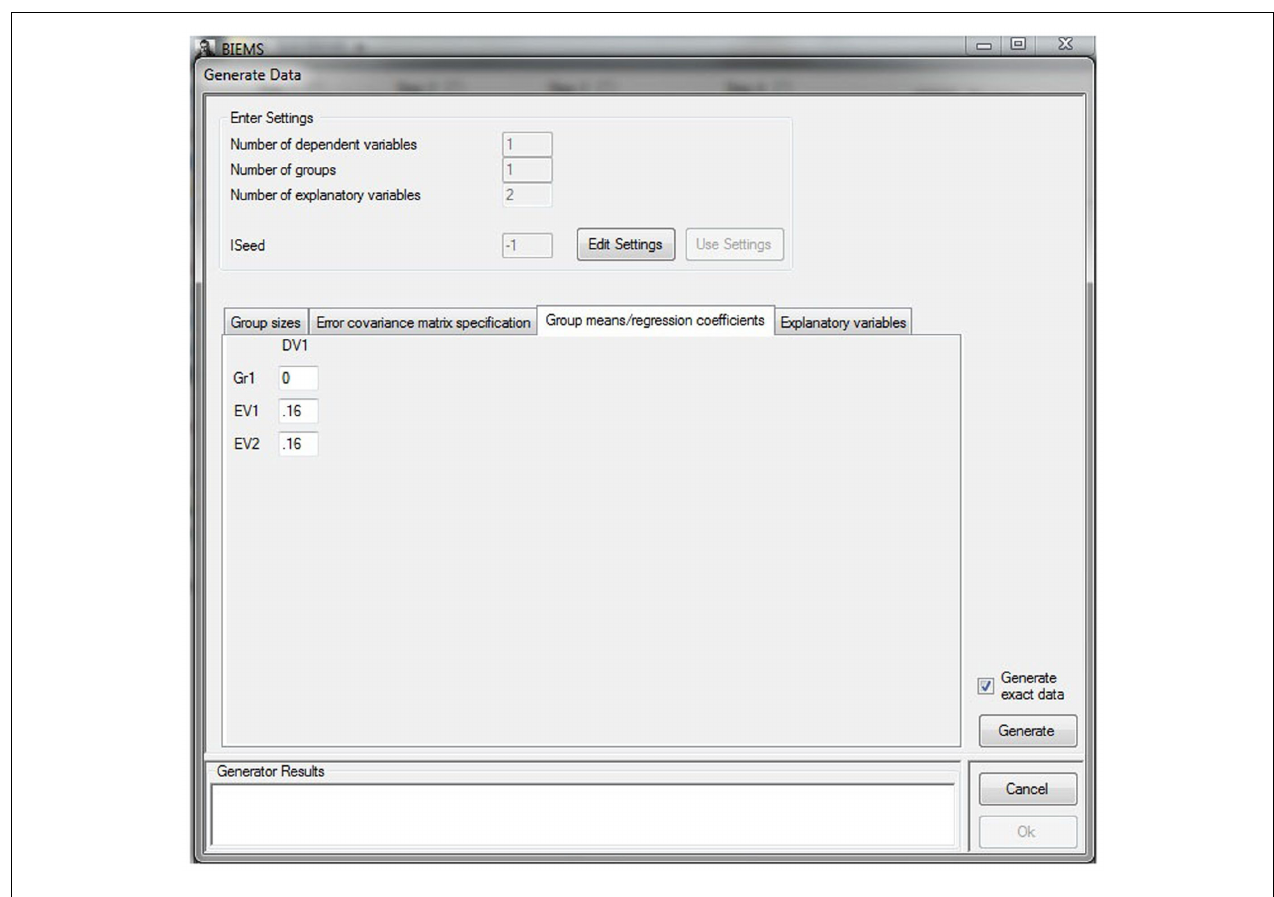
FIGURE 5 | Generating datasets with BIEMS.